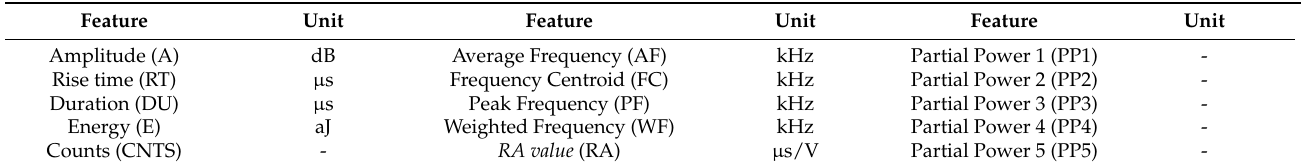
Table 3. Features selected for the unsupervised learning